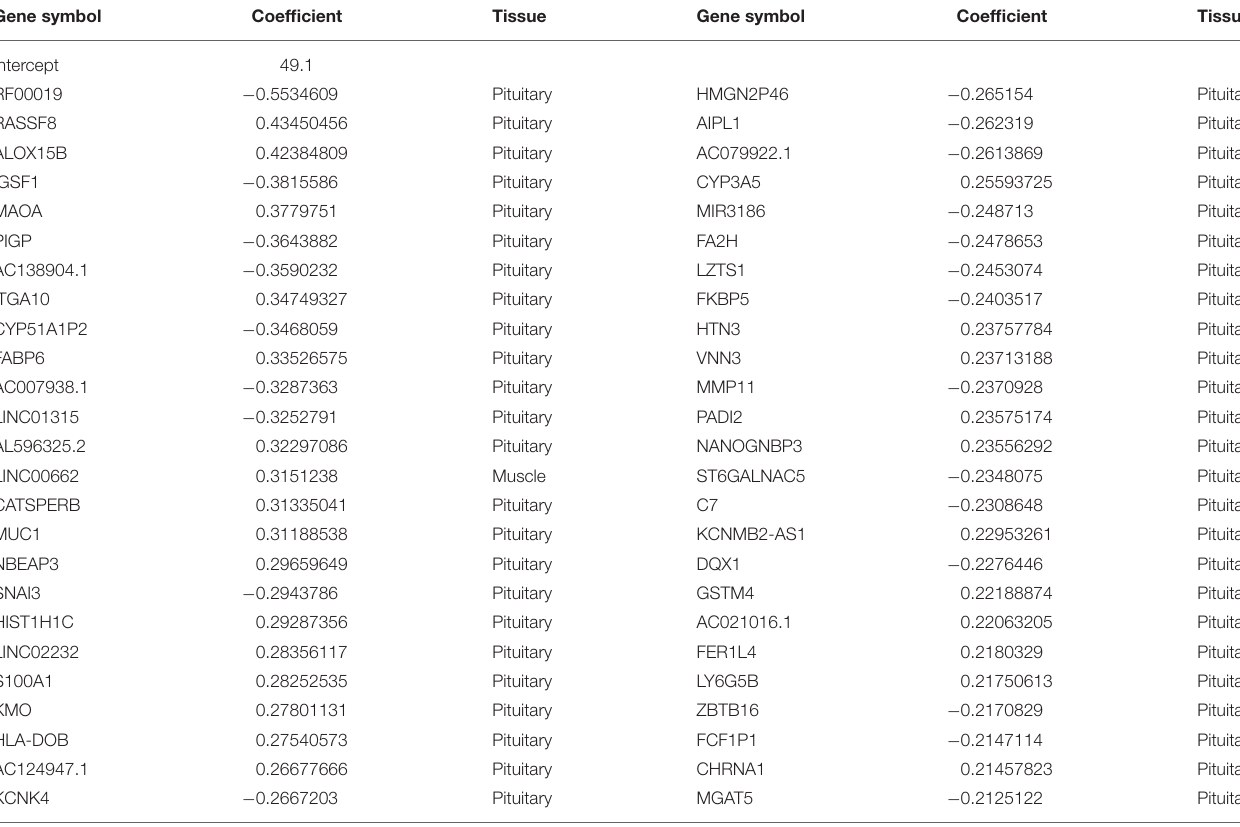
TABLE 4 | Best models for age prediction using pituitary & muscle skeletal